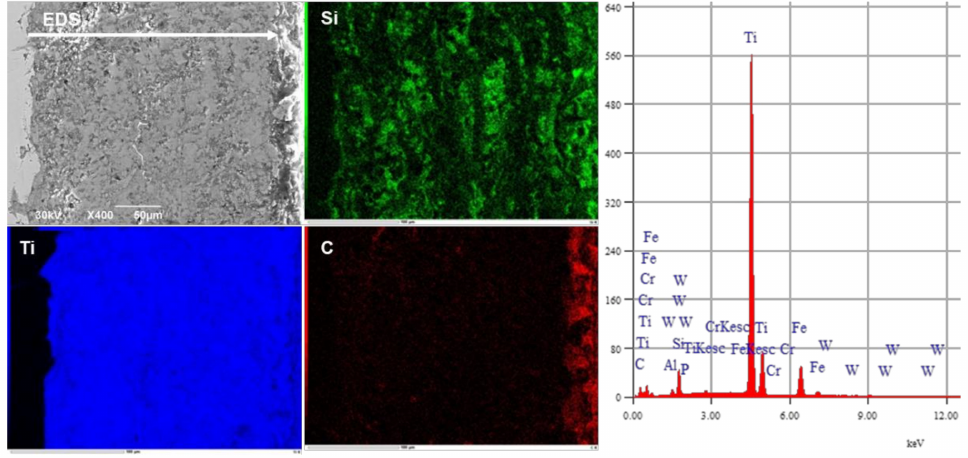
Figure 4. Cross-sectional microstructure of coatings with a color image of EDS mapping after PPT at a distance of 50